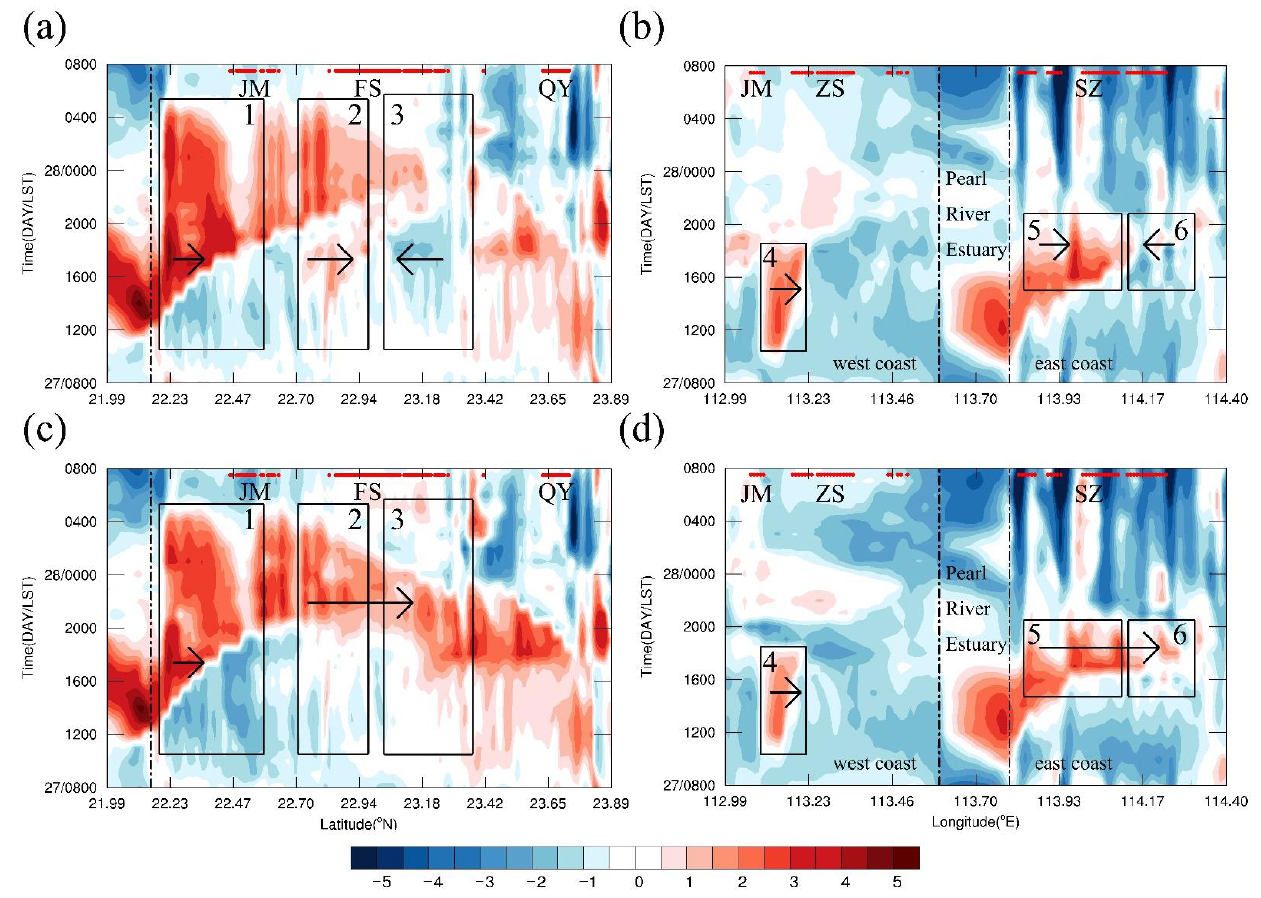
Figure 6. Hovmöller chart of 10 m wind component (unit: m/s) along the crossline AB ( a , c ) and CD ( b , d ) for CTRL ( a , b ) and NoUrb ( c , d ) experiment, the shaded in the left column is v component, and the right is u component, the time axis is 0800 LST 27 December to 0800 LST 28 December, the black dotted lines indicate sea and land boundary, the red dots are city underlying surface and the letters are abbreviated for cities. Solid boxes 1 – 3 and 5 – 6 are UHICs in Jiangmen, southern and northern Foshan, western and eastern Shenzhen, respectively. Box 4 is the West River breeze. The arrows indicate the flow moving directions in the plane.